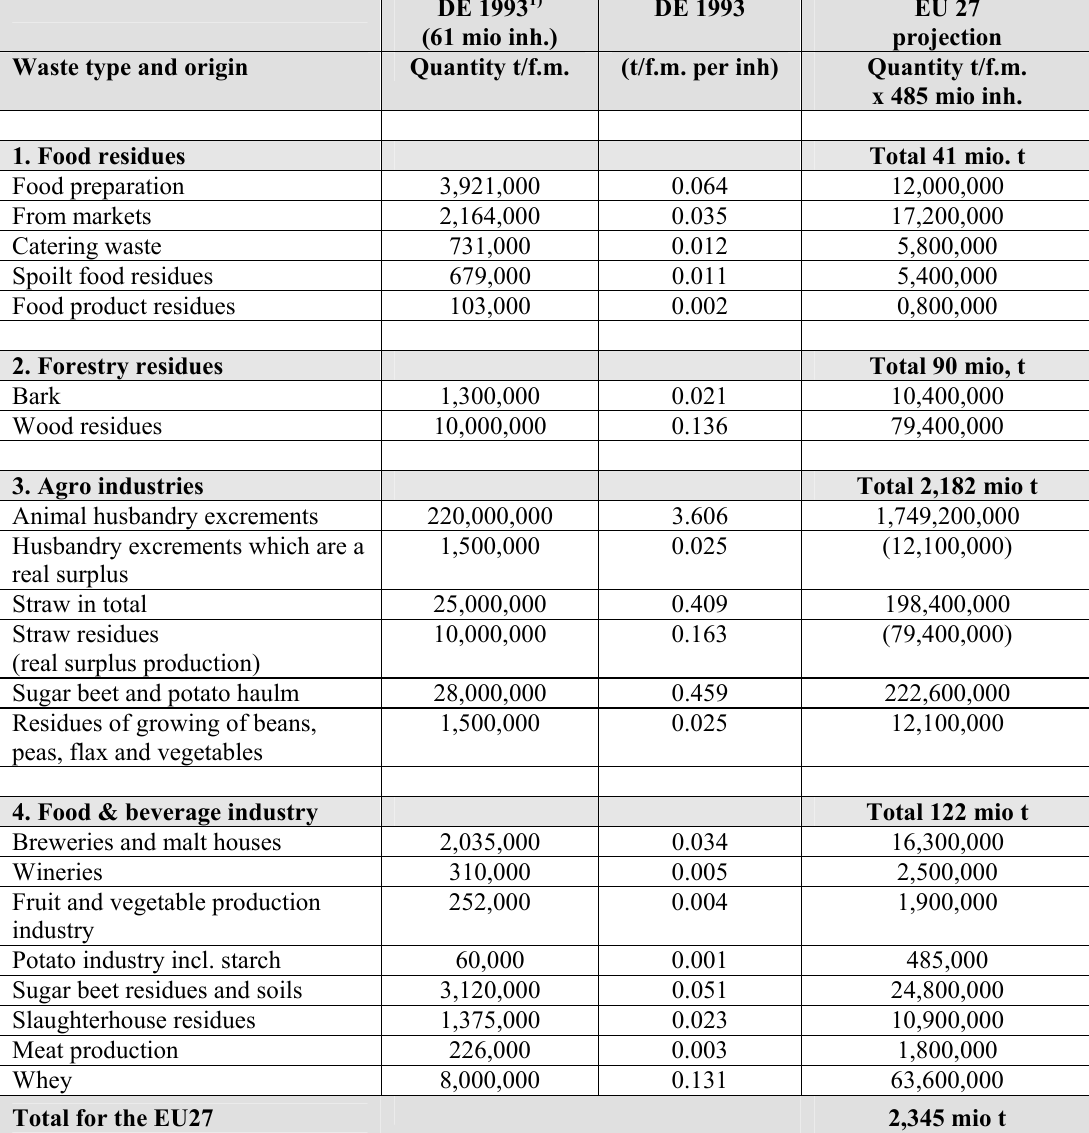
Table 41: Amount of organic residues in Germany which not belong to household waste and EU27 projection DE 1993